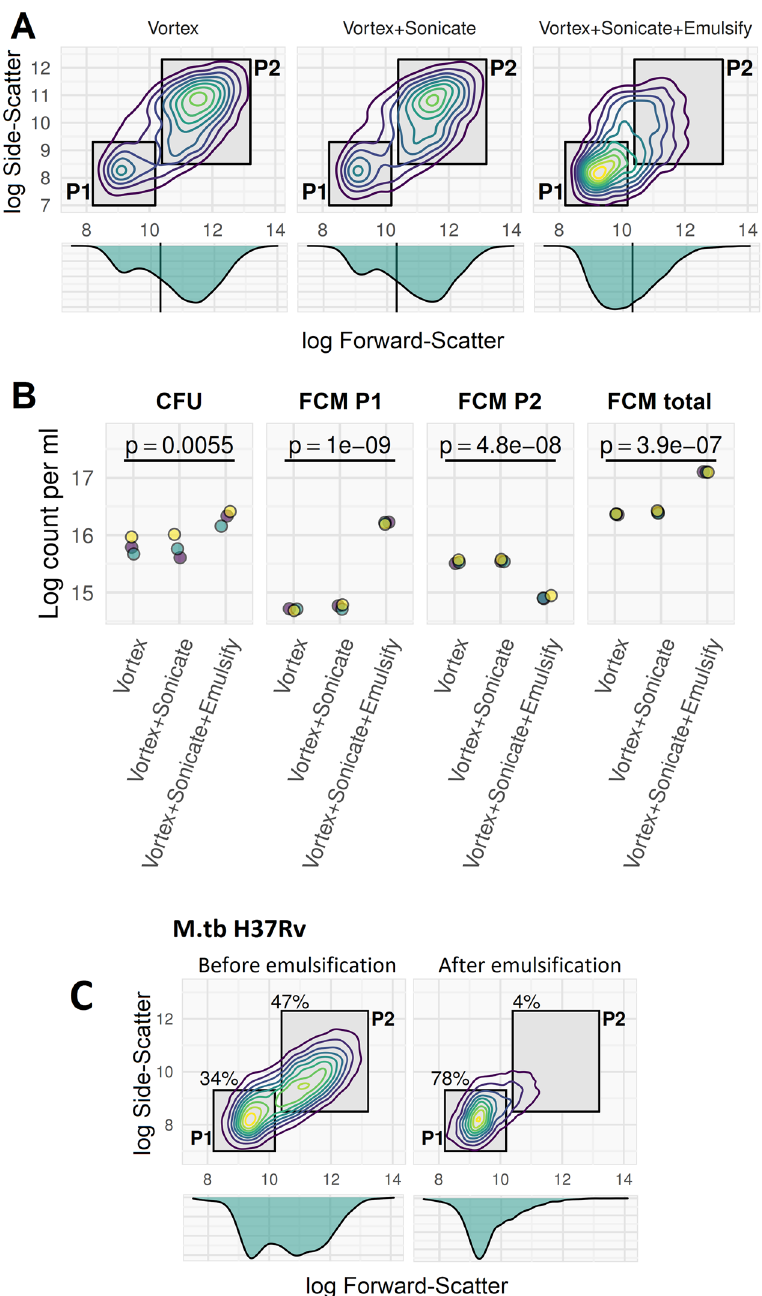
Figure 3. Needle-emulsification, but not vortex or sonication, disrupt clumps and increases cell counts. Mid-log phase culture of M. smegmatis ( A , B ) and M. tuberculosis H37Rv ( C ) grown in 0.15% v/v Tween80 7H9 with 150 rpm agitation and diluted tenfold in 0.15% v/v Tween80 PBS and stained with Calcein-AM prior to FCM on a BD Accuri C6. Data acquisition with thresholds SSC > 1000 and FL1 > 2000. Samples were processed by 60 s vortex, or by 60 s vortex followed by 5 min sonication in water bath, or by both these methods followed by needle emulsification (12 passes through a double Luer lock- ended, 25 Gauge, 4-inch, micro-emulsifying needle with a reinforcing bar (Cadence Inc.). ( A ) Two populations are seen which are differentiated by light-scatter: single cells (P1) and clumps (P2). Qualitatively, vortex and sonication processing did not disrupt P2 population (clumps), but needle emulsification (far right plot) shifted events from predominantly P2 (clumps) to predominantly P1 (single cells). ( B ) Counts of CFUs or FCM events with three-replicates from 3 independent cultures (purple, green, yellow dots). Emulsification resulted in a greater number of CFU and decreased the P2 count while increasing the P1 count substantially. The apparent total cell counts were increased by emulsification by an order of magnitude: both CFU count and total flow cytometry CA positive count increased by half to one unit on log scale. This can be interpreted as resulting from clumps (P2 population) being disaggregated into single cells (P1). The p-values were determined from repeated-measures ANOVA by cell-disruption method. ( C ) Needle emulsification procedure has same effect on clumping in M. tuberculosis H37Rv (processed without vortex and sonication